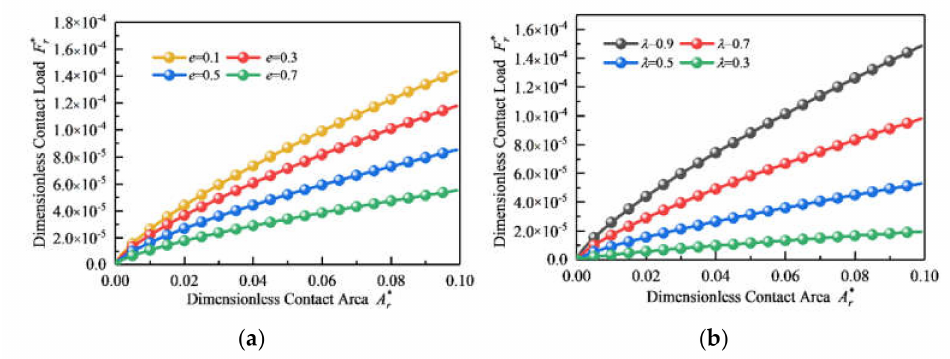
Figure 13. Variations in the dimensionless contact area A ∗ r with fractal dimension D : ( a ) different eccentricity e ; ( b ) different contact coefficient λ